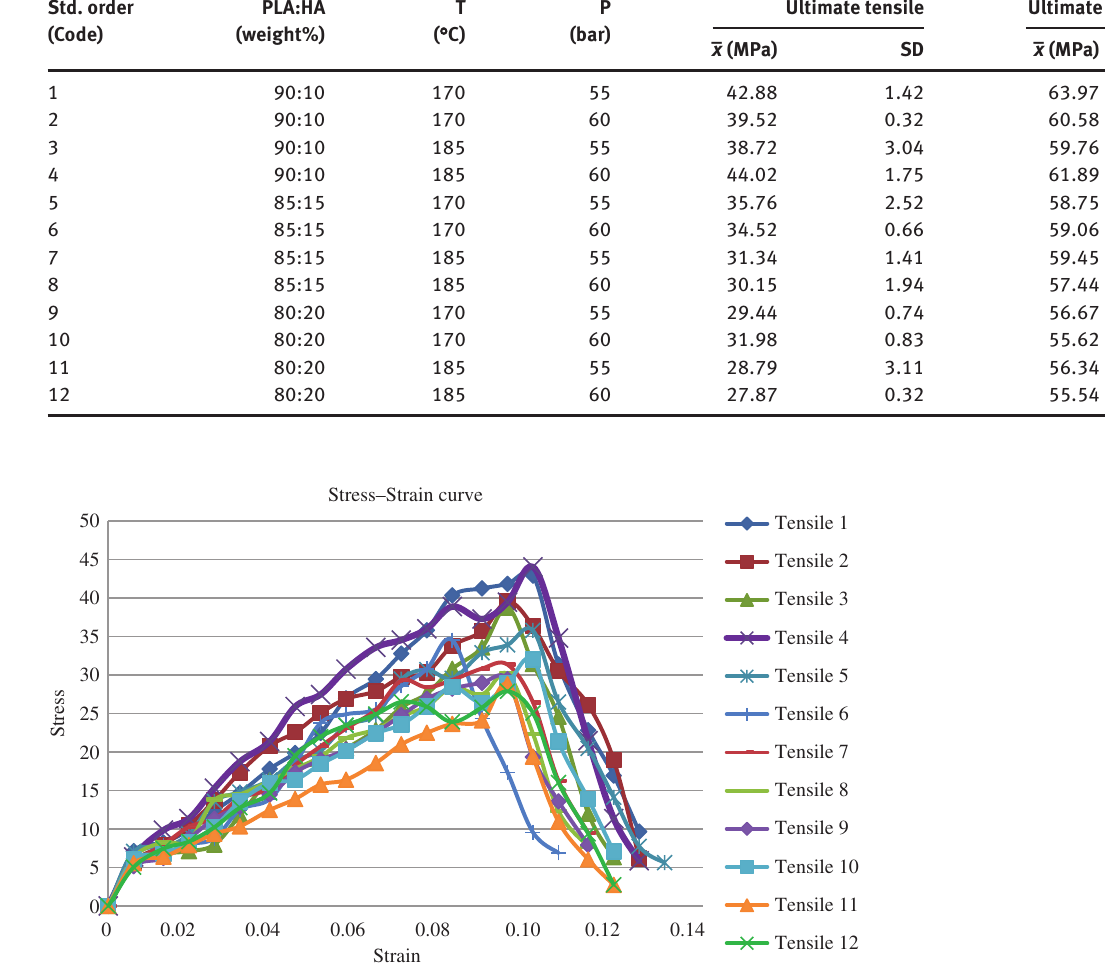
Table 4: Average and standard deviations of tensile and bending strengths. Std. order